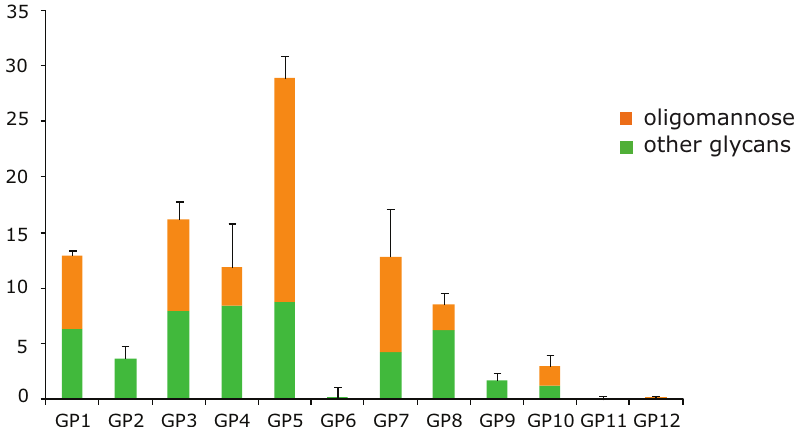
Figure 1. Contributions of individual glycan groups (GP1-GP12) to the cell membrane N -glycome. Contributions of mannose-bearing glycans within each individual group are colored in orange.